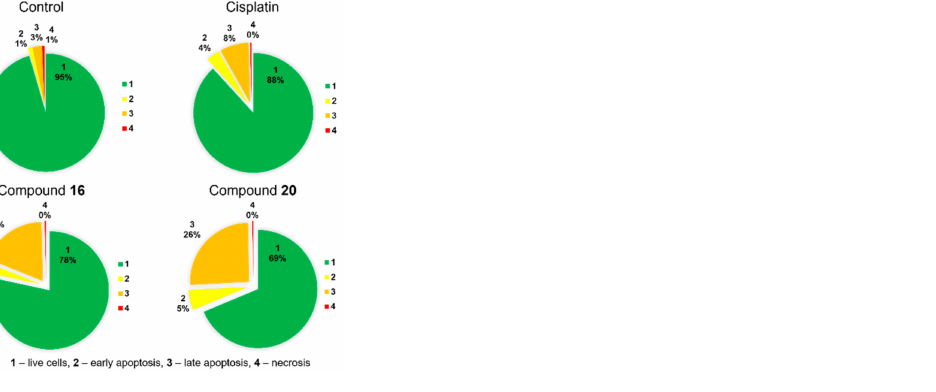
Figure 8. Parameters of cell death detectable by flow cytometry in HCT116 cells treated with 16 , 20, and cisplatin. Shown is one representative experiment out of four with similar results.